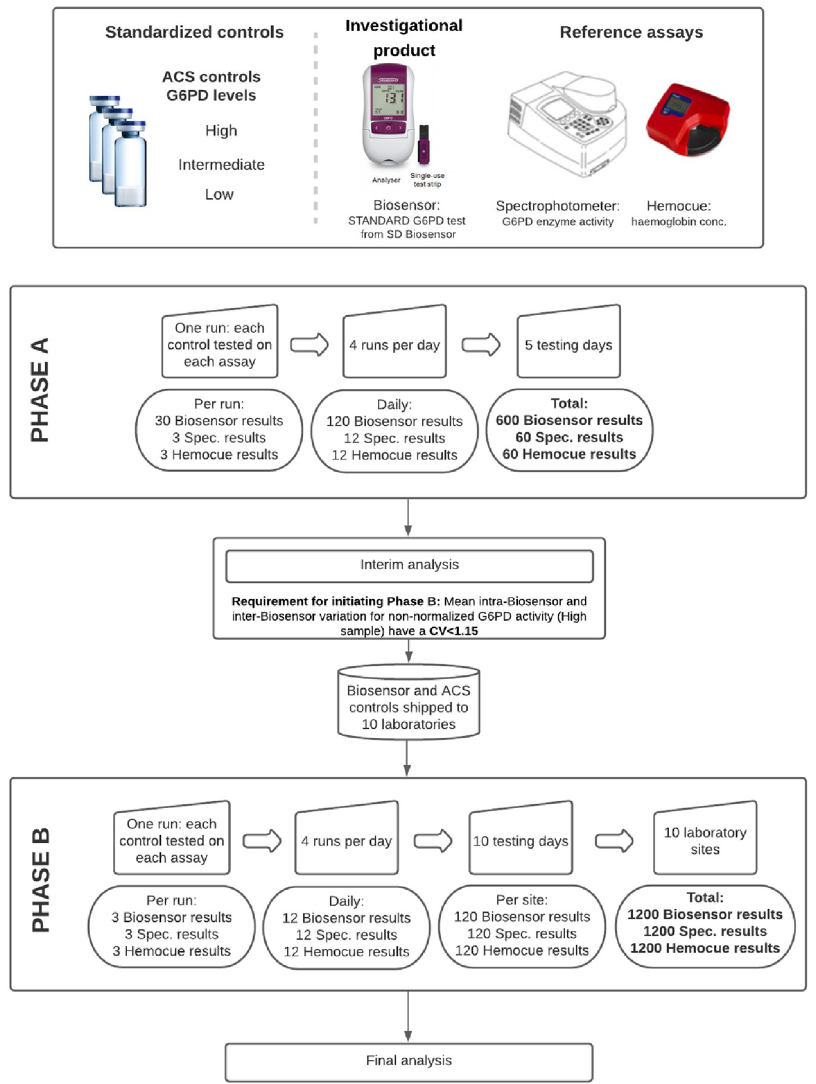
Fig 1. Schematic overview of the study design. CV: coefficient of variation. (Images reproduced with permission from SD Biosensor and